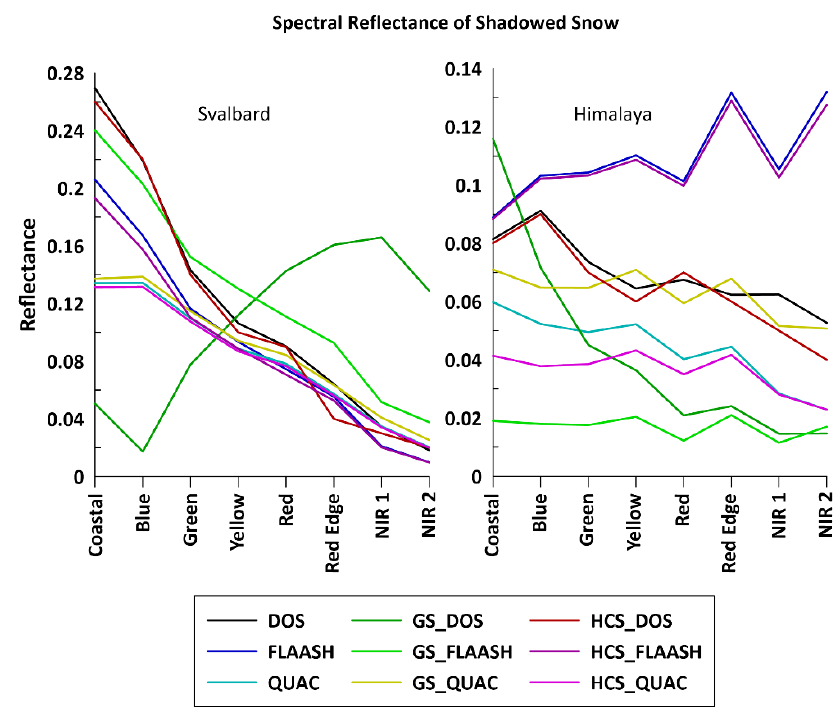
Figure 11. Spectral reflectance of shadowed snow derived across all processing schemes. The left graph shows the reflectance of shadowed snow in Svalbard, whereas the graph on the right shows the reflectance of shadowed snow in the Himalayas.